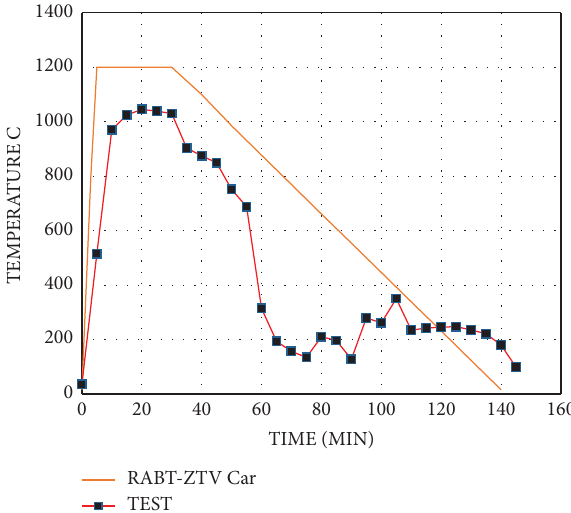
Figure 3: Time-temperature curves produced by test setup and the